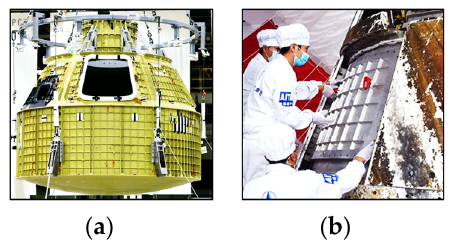
Figure 1. Schematic diagrams of the spacecraft. ( a ) Spacecraft thin-wall structure (from